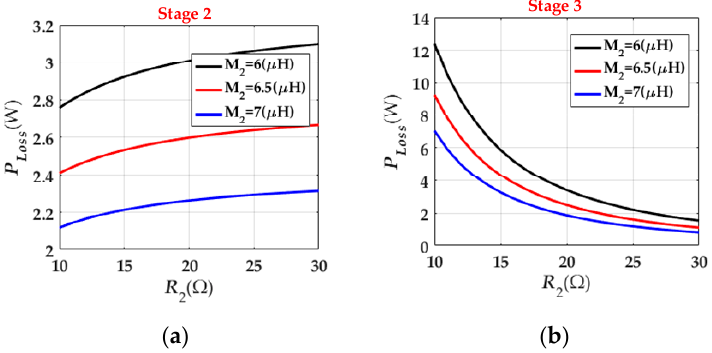
Figure 10. The variation of the loss P Loss with the load and the mutual inductance in Mode B. ( a ) The loss analysis of Stage 2; ( b ) the loss analysis of Stage 3.